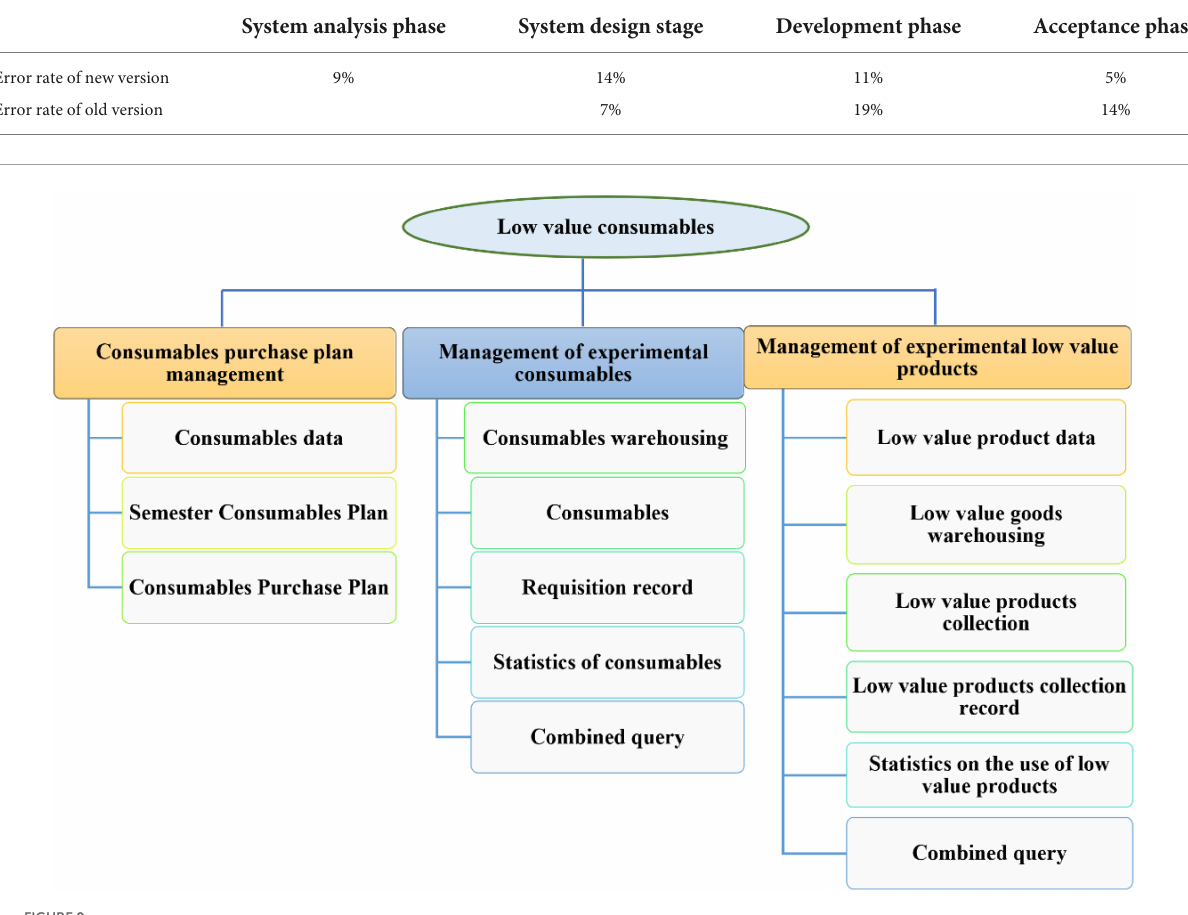
TABLE 3 Specific data.